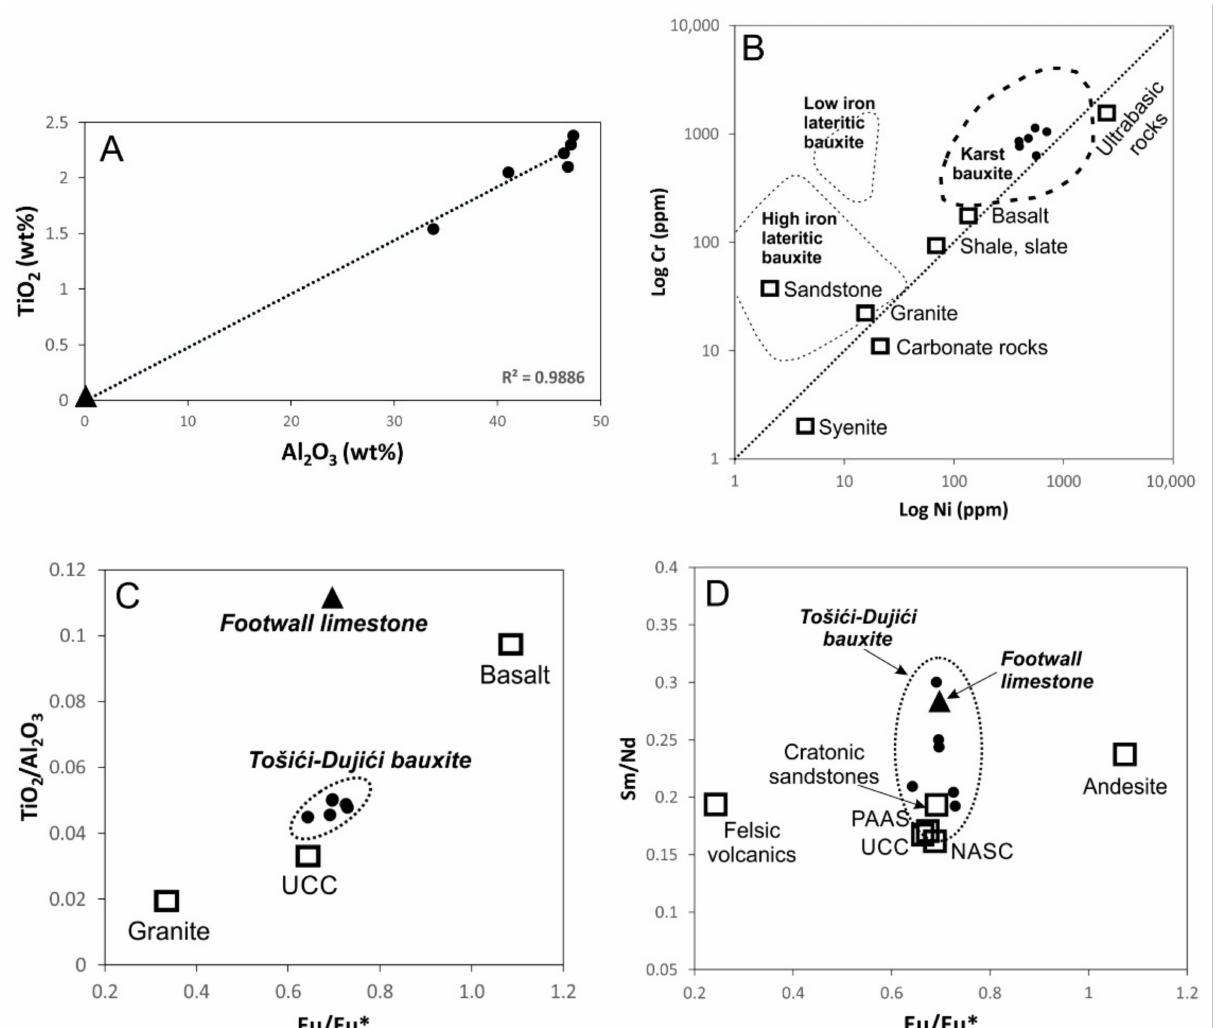
Figure 9. Binary diagrams of selected geochemical data suggesting provenance of detrital material for bauxite of the Toši´ci-Duji´ci deposit: ( A )—Al 2 O 3 and TiO 2 binary plot showing immobility of Ti in the bauxite samples ( • ) and footwall limestone ( (cid:78) ); ( B )—LogNi and LogCr binary diagram showing affinity of the Toši´ci-Duji´ci bauxite to the karst bauxite signature; ( C )—Eu/Eu* and TiO 2 /Al 2 O 3 binary plot showing the bauxite geochemical signature to be closely related to UCC (data from [35]); ( D )—Eu/Eu* and Sm/Nd binary plot indicating a close connection of the Toši´ci-Duji´ci bauxite to UCC, NASC, PAAS, and cratonic sandstones (data from [35,46]) but also likely heterolithic origin of detrital material suggested by a spread of Sm/Nd